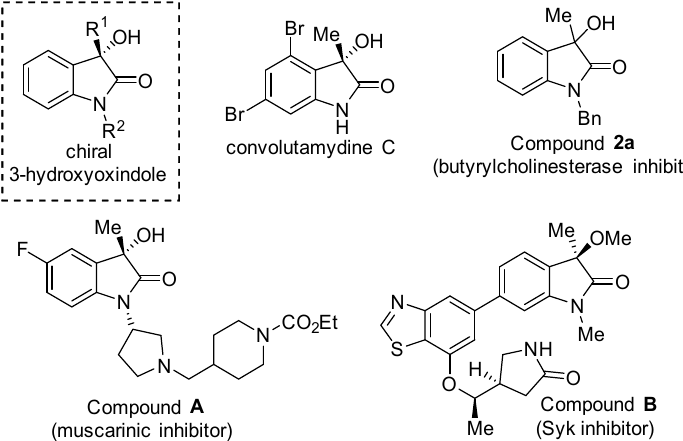
Figure 1. Biologically active 3-hydroxy-3-methyl-2-oxindole